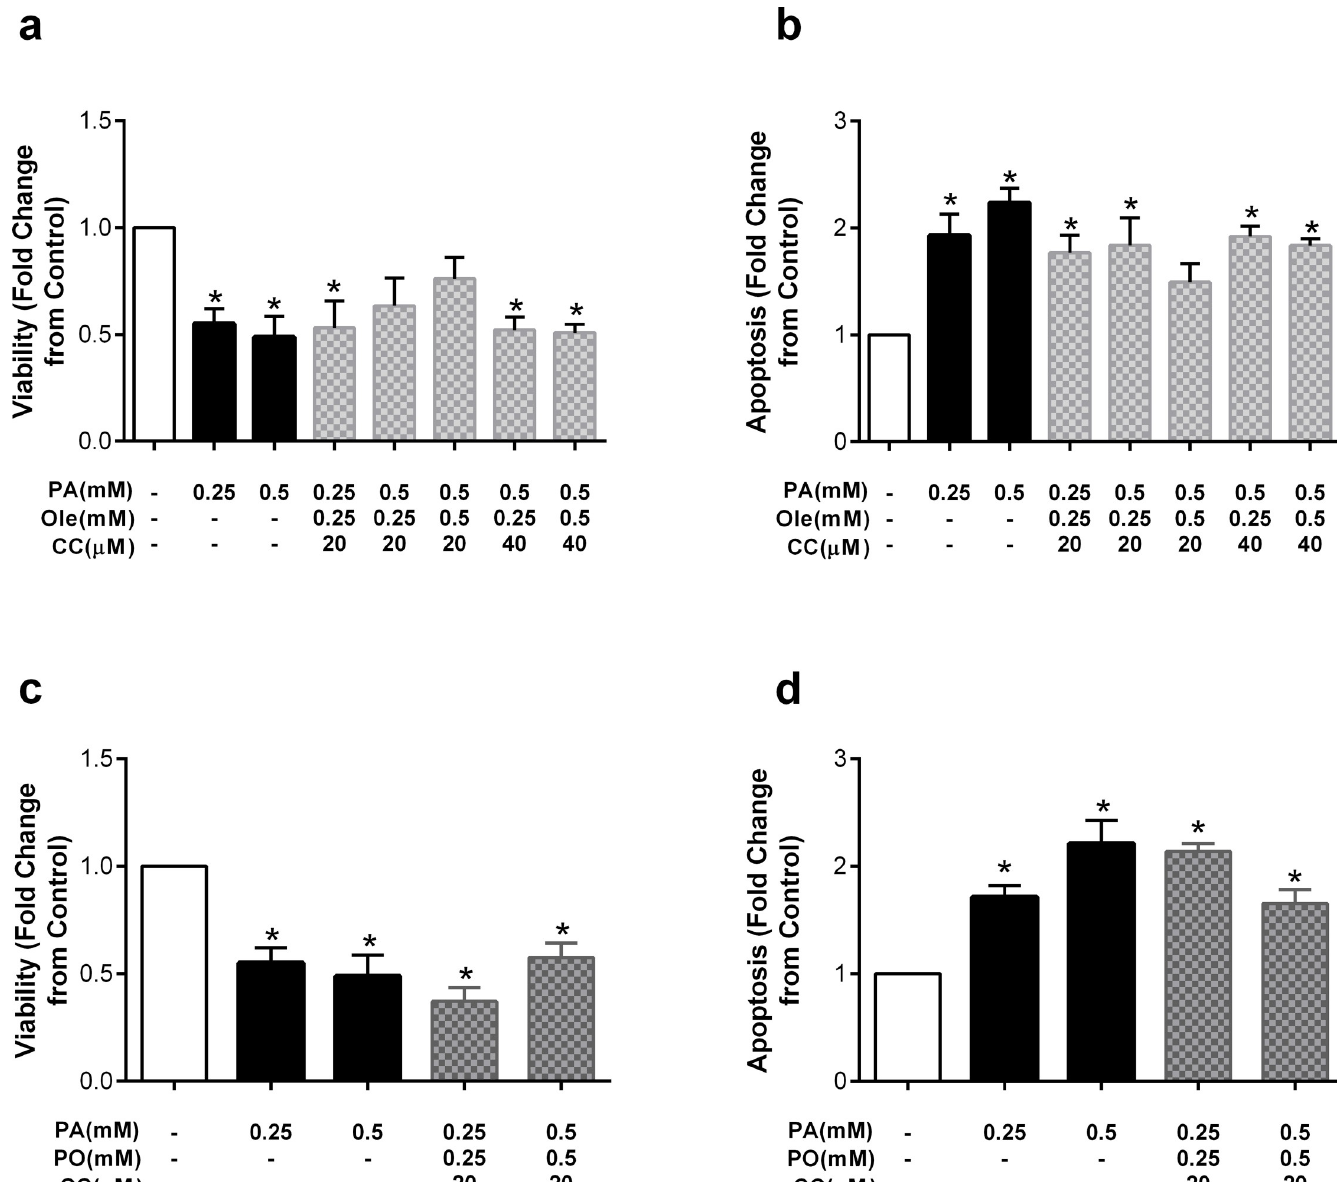
Fig 10. The AMPK inhibitor CC prevents protective effects of the monounsaturated fatty acids oleate and palmitoleate. Cells were pretreated with compound C (CC; 20 or 40 μ M) and then co-incubated with a combination of palmitate (PA) and oleate (Ole) or palmitoleate (PO). Fold change from control in a) viability with Ole, b) apoptosis with Ole, c) viability with PO and d) apoptosis with PO after co-treatment with palmitate (PA) and compound C (CC). Data are expressed as mean ± SEM; n = 3–5 independent experiments; � p < 0.05 vs